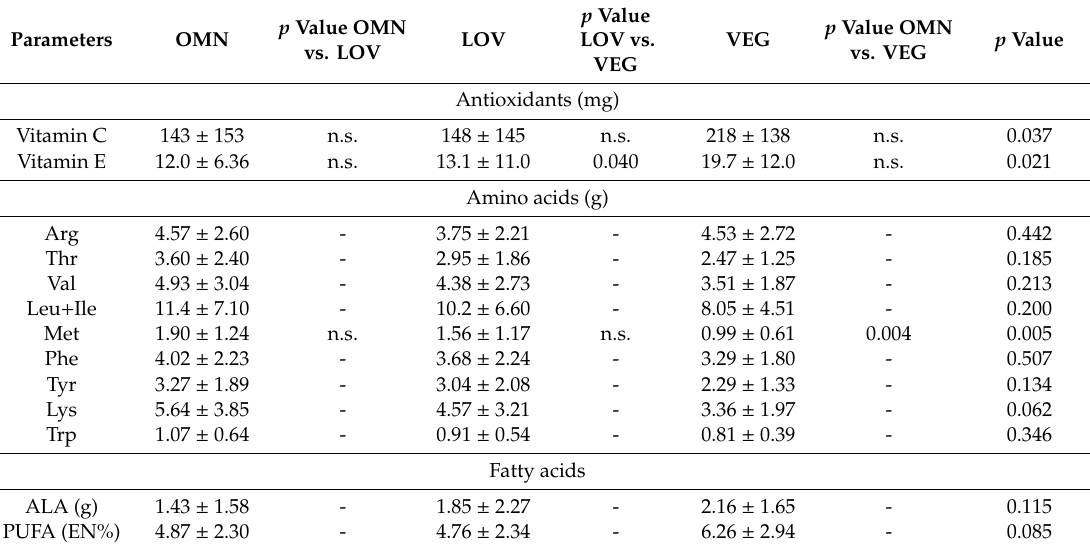
Table 2. Dietary intake of antioxidants and amino acids (mean ± SD) by diet